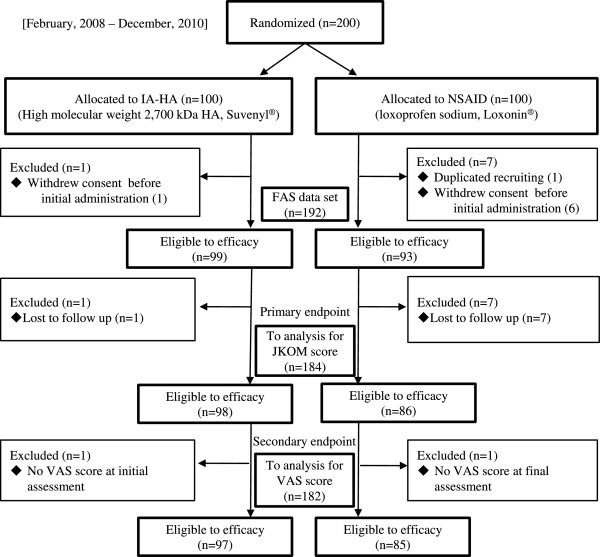
A flow chart of the study. FAS, full analysis set; HA, hyaluronic acid; IA-HA, intra-articular injections of HA; ITT, intention-to-treat; JKOM, Japanese Knee Osteoarthritis Measure (JKOM); NSAID, non-steroidal anti-inflammatory drug; VAS; visual analog scale.